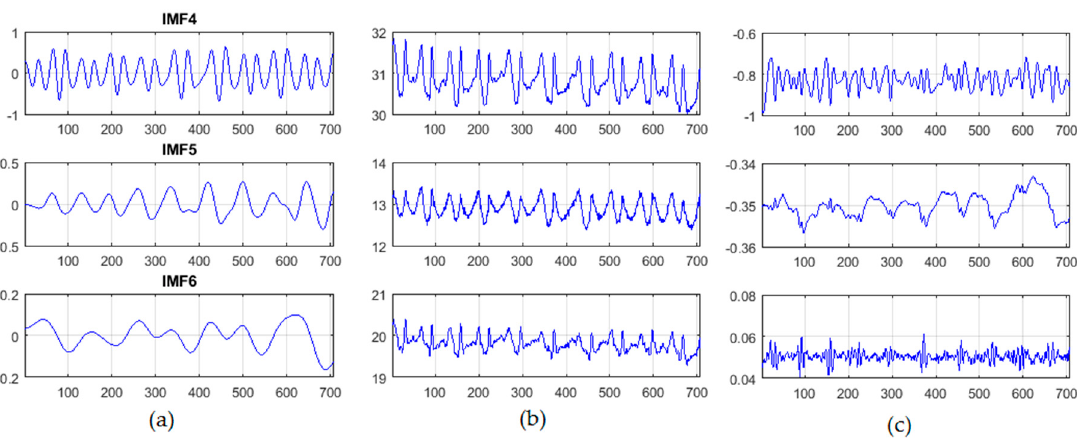
Figure 5. The canonical correlation analysis (CCA) technique ( a ) The selected IMF components (S) ( b ) Transformation [ x = WS], where W is an un-mixing matrix and ( c ) CCA outputs [ y = CCA ( x )].